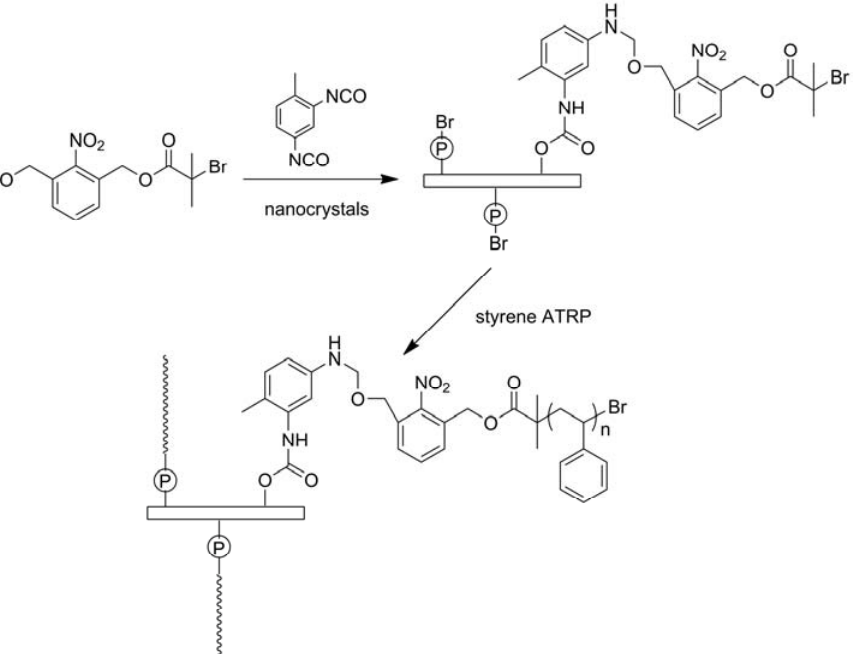
Figure 13. Synthesis route of nanoparticles with photocleavable PS grafts. Reprinted with permission from [73]. Copyright 2012 Royal Society of